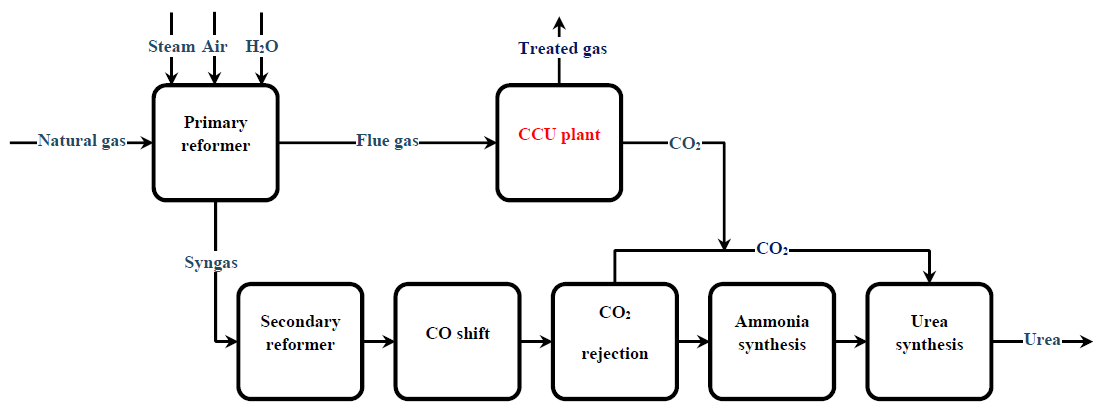
Figure 1. Block flow diagram of the case study.